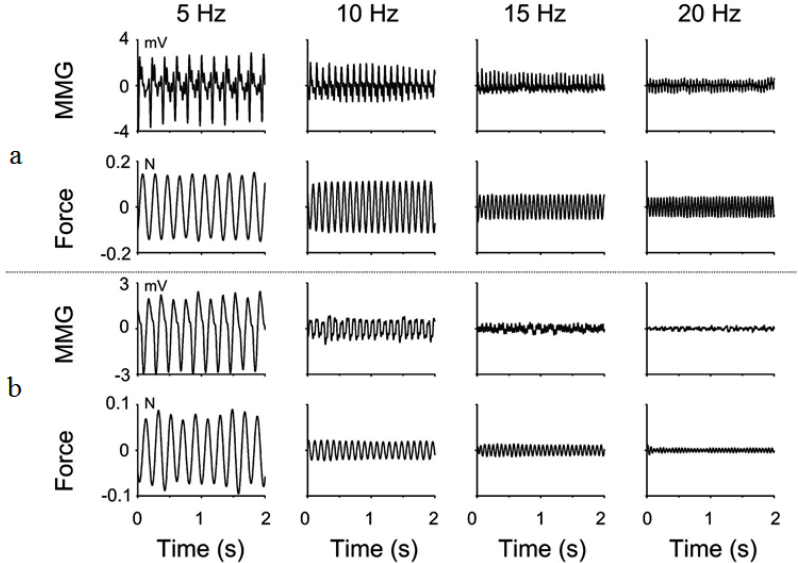
Figure 3. Relationship between MMG amplitude and force during repetitive electrical stimulation (5 Hz, 10 Hz, 15 Hz, 20 Hz) of a motor unit (MU) ( a ) MU with shortest twitch duration (163.2 ms) ( b ) MU with longest twitch (220.6 ms) from the media gastrocnemius muscle of a healthy volunteer. Systematic reductions in the MMG amplitude and force reductions were evident as the stimulation frequency increased